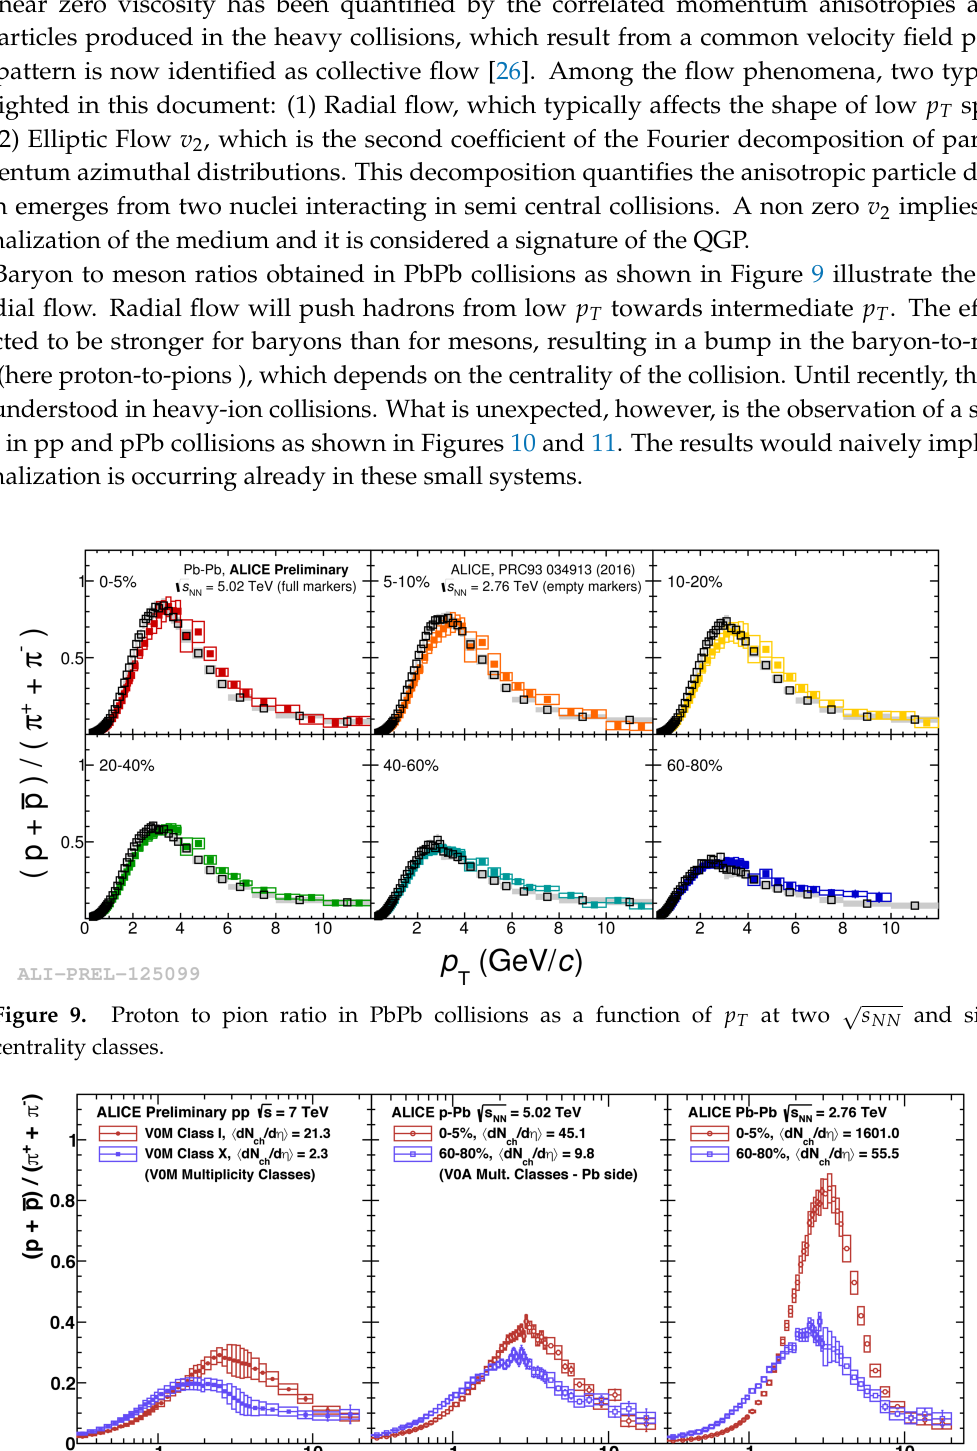
Figure 10. Proton to pion ratio as a function of p T in pp ( left ), pPb ( middle ) and PbPb ( right ) collisions. The measurements are classified as a function of charged particle